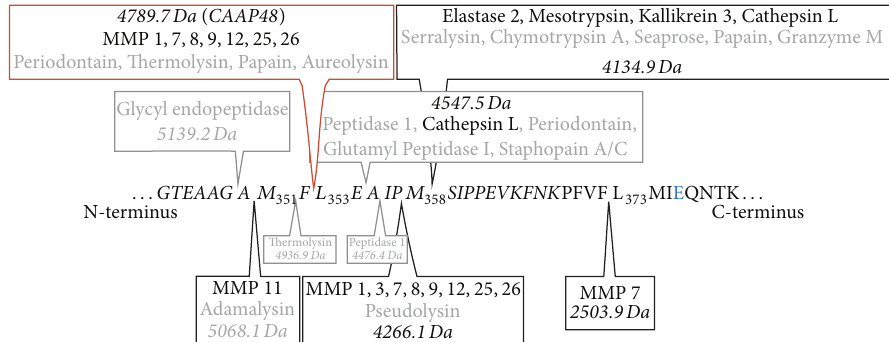
Figure 8: Cleavage sites in the AAT reactive center loop (RCL). Shown are the known cleavage sites in the RCL (italic) of AAT with respective enzymes gathered from the MEROPS database [29]. Human proteases are displayed in black and proteases of other species in grey. Also for every cleavage site the respective molecular weight of the C-terminal peptide is indicated. Cleavage between Phe 352 and Leu 353 leads to the generation of CAAP48 (red frame). However in the presence of SNP rs1303 cleavage at this site leads to the generation of CAAP47, a peptide with an E > D substitution at the position indicated in blue.